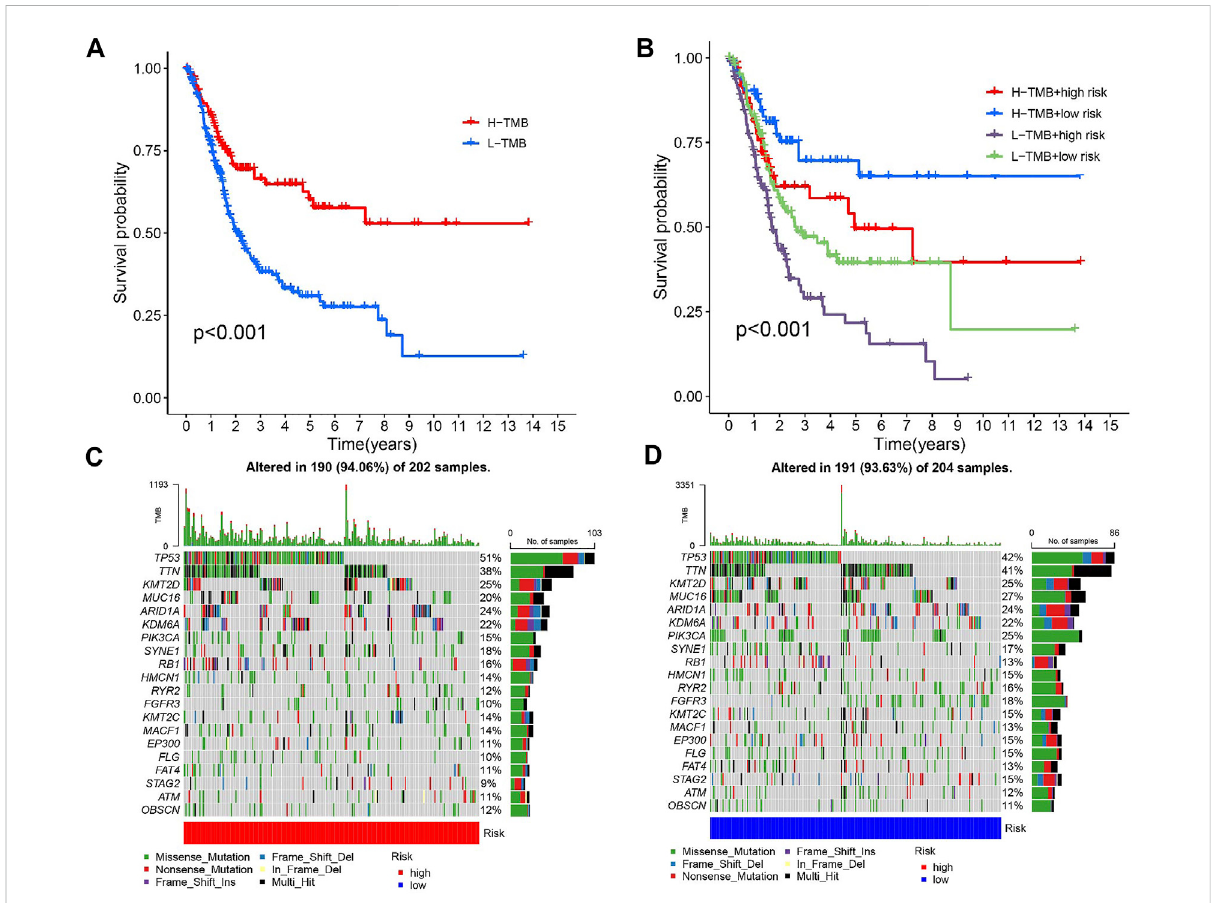
Supplementary Figure S2G. In conclusion, RS can be used as an indicator to assess the prognosis of BLCA.